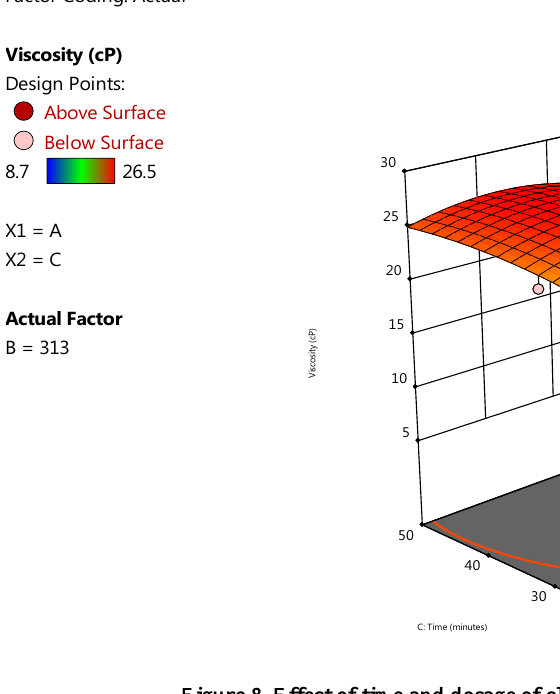
Figure 8. Effect of time and dosage of clay on viscosity of OBMC